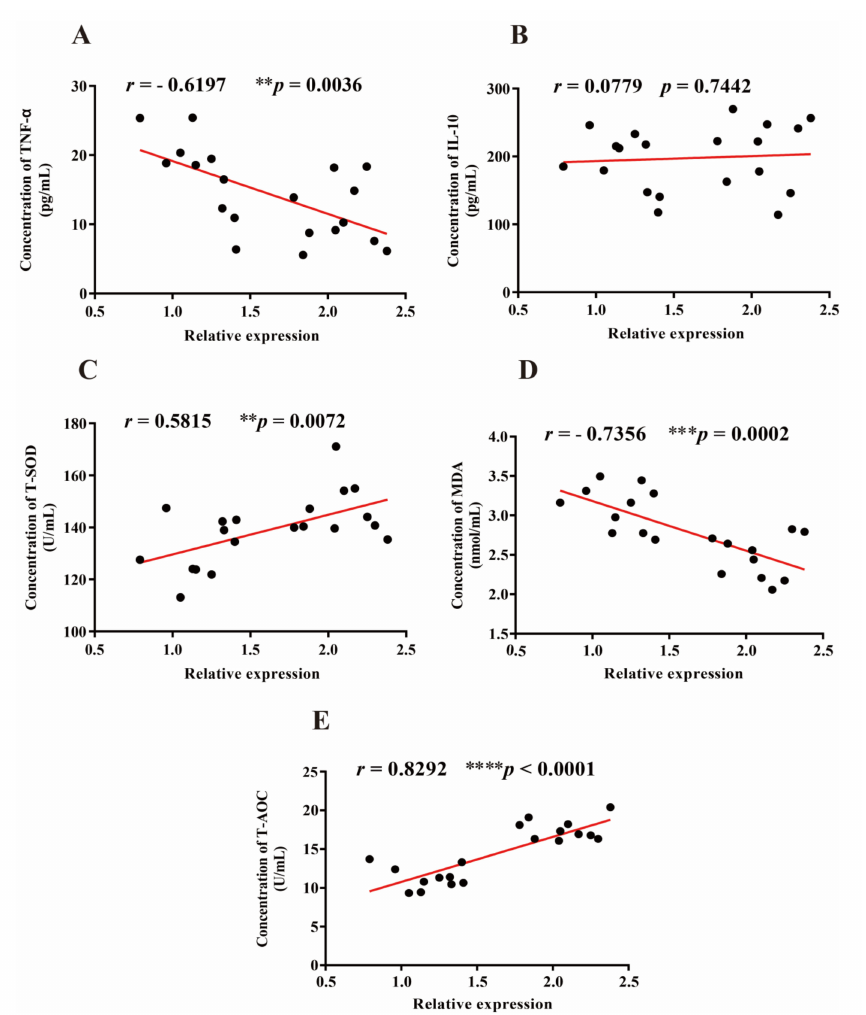
Figure 5. Correlation between the expression of Lactobacillus , oxidative, and inflammatory mark- ers. Rank tests with Spearman’s correlation coefficient were used to assess correlations between Lactobacillus and oxidative markers (T-SOD, MDA, T-AOC), pro-inflammatory marker (TNF- α ), and anti-inflammatory marker (IL-10). Asterisks indicate significant differences (Compared with baseline values, ** p < 0.01, *** p < 0.001, **** p < 0.0001). n = 10 volunteers per